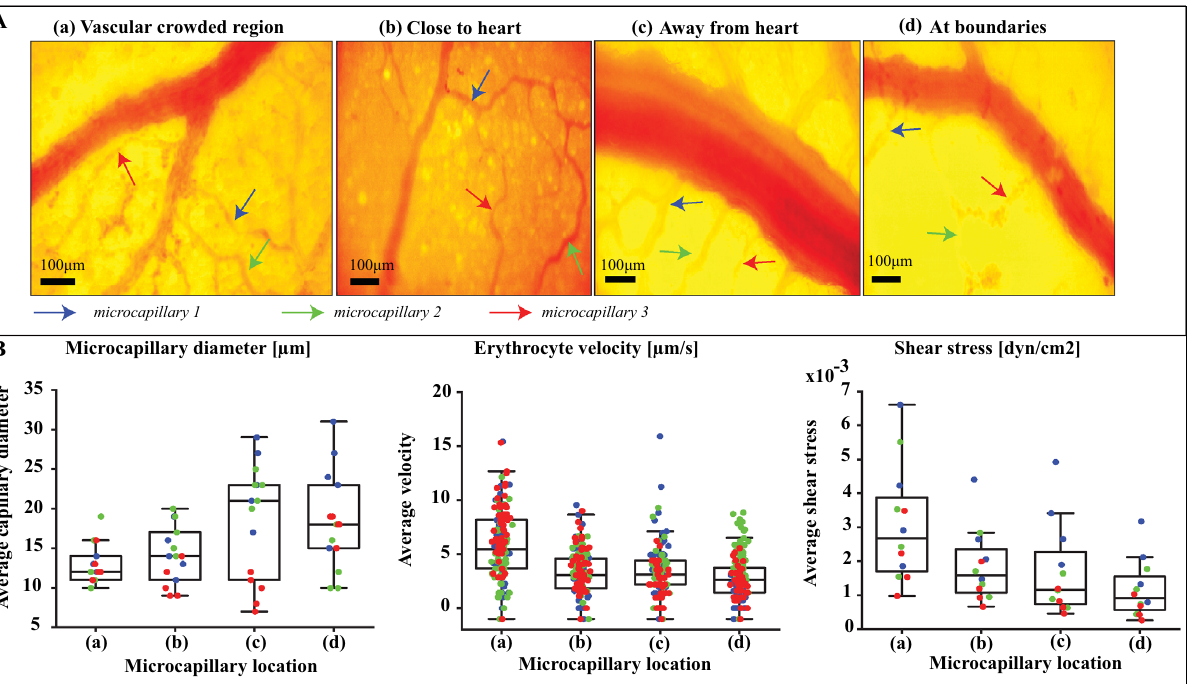
Figure 6. Vessel diameter and erythrocytes velocity estimation within individual microcapillaries using SDF microscopy. Panel ( A ) shows the time-averaged snapshots of microcapillaries organization at multiple locations of chick vascular networks. Three capillaries from each locations highlighted with colored arrows were selected for quantitative analysis. Panel ( B ) shows the quantitative analysis similar to Fig. 2B were performed on the selected microcapillaries from different locations to approximate the diameter and erythrocytes velocities. These values were served as an input for computational modeling to estimate the shear stress. For the shear stress profile, erythrocyte movements and tracking see Supplementary Figure S3, Supplementary Videos S10 and S11,